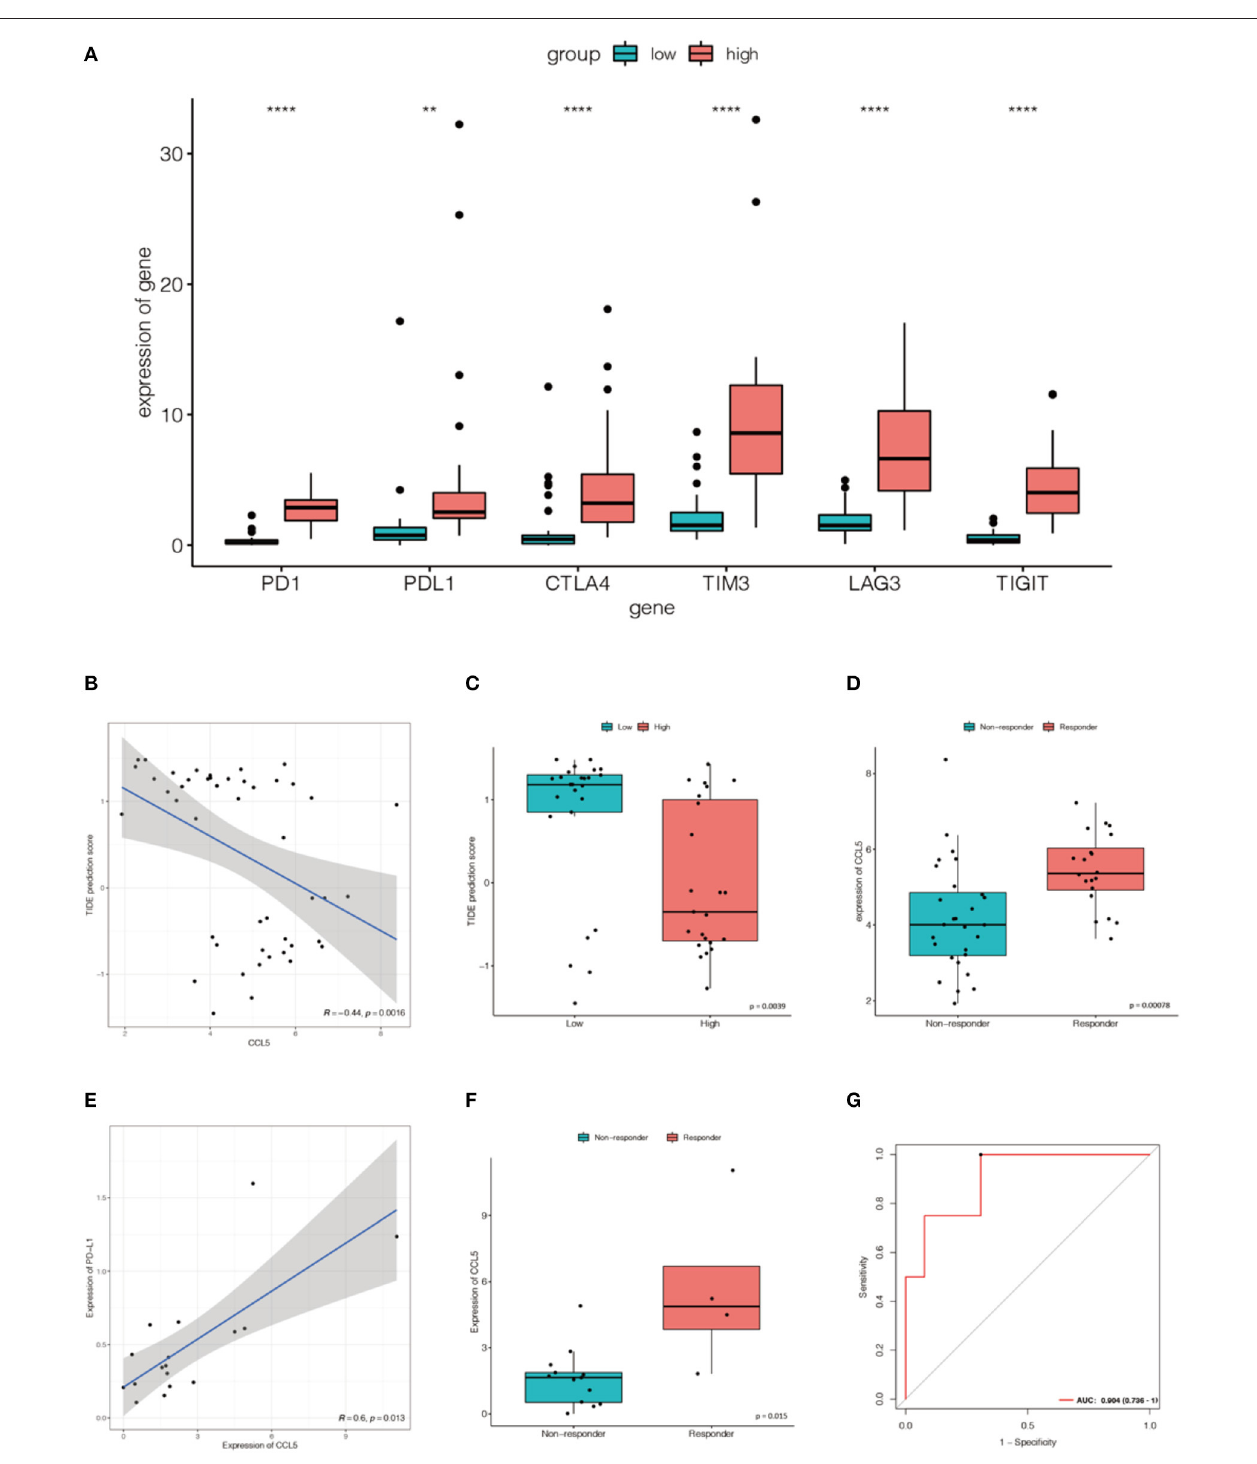
FIGURE 7 | (A) The expression of ICPs in the high CCL5 expression group was significantly greater than that in the low CCL5 expression group in the Jiang cohort (** P < 0.001; **** P < 0.0001). (B) Relationship between TIDE and CCL5 expression in the Jiang group. (C) Distribution of TIDE scores in the high- and low-expression groups. (D) CCL5 expression in the Jiang cohort differed between responders and non-responders. (E) The expression of CCL5 was positively correlated with that of PD-L1 in Roper’s cohort ( p < 0.05). (F) CCL5 expression in the Roper’s cohort differed between responders and non-responders. (G) Receiver operating characteristic (ROC) curve of CCL5 in Roper’s cohort (AUC = 0.904).